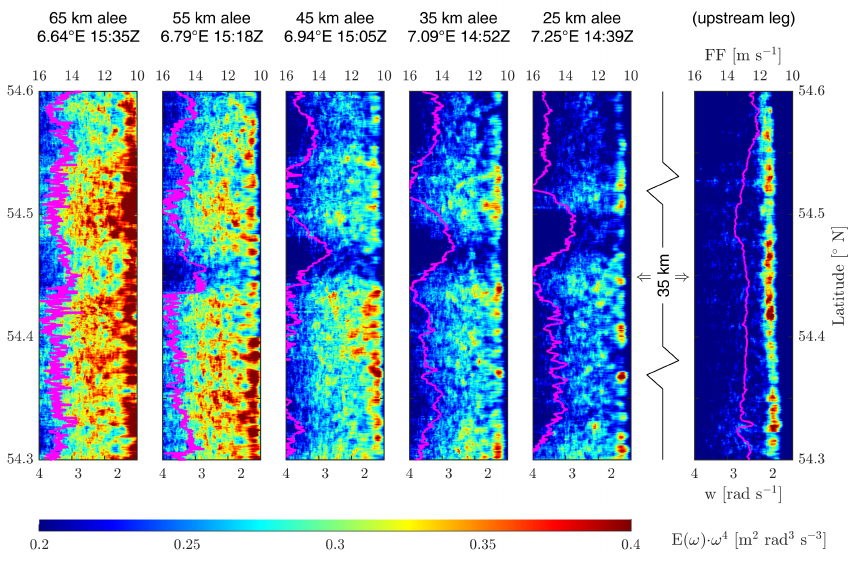
Figure 4. Sea surface energy distribution (variance density multiplied with ω 4 , colour coded) for the flight downstream of the wind park cluster N4 on 8 August 2017 with wind direction from the East. The wind speed measured at hub height is represented as an overlay in